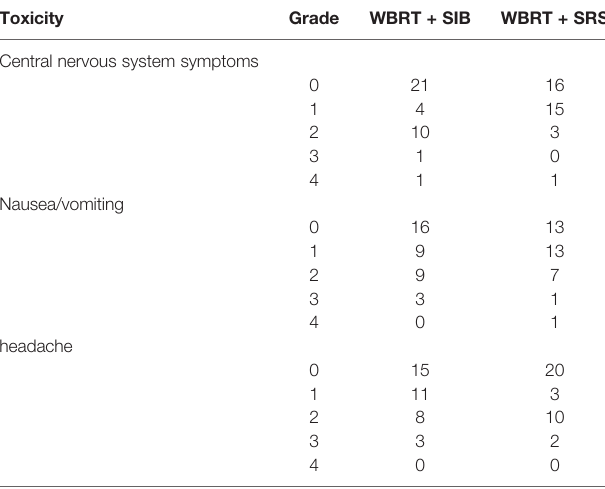
TABLE 6 | Toxicity associated with radiotherapy. Toxicity